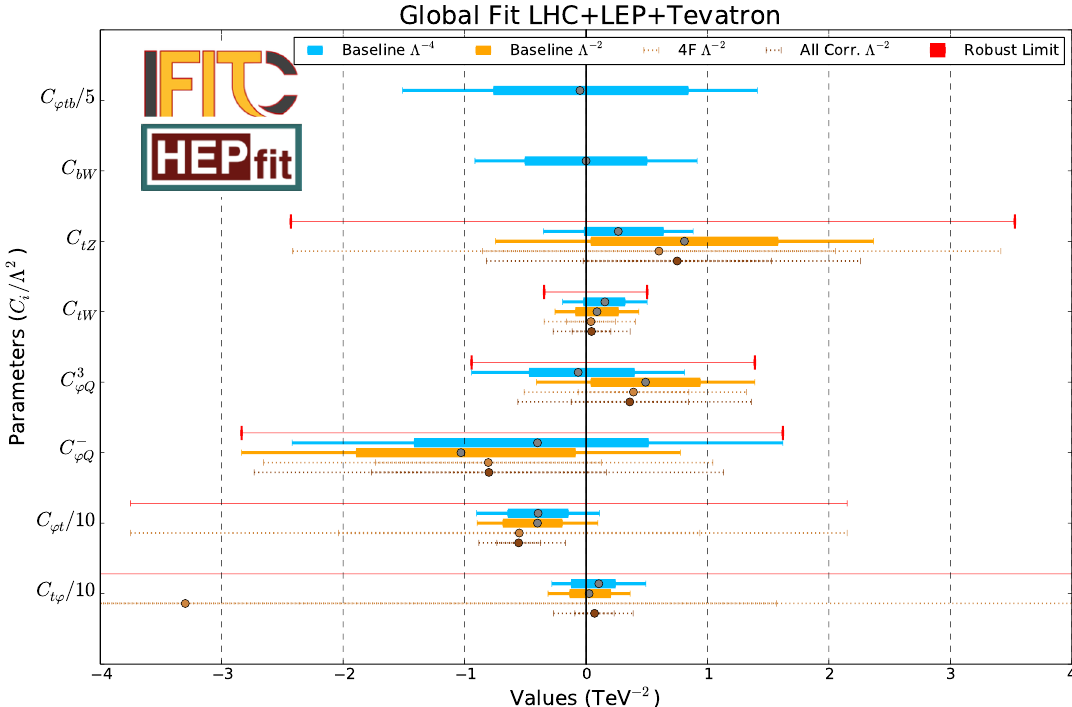
Figure 4 . Results of the global fits with O (Λ − 2 ) (in orange) and O (Λ − 4 ) (in blue) terms. The two thin lines below each of them correspond to additional fits performed to test the robustness of the results: to account for the effects of the inclusion of further operators and for the correlations between all the different measurements (as described in section 8). The red markers correspond to the envelope of those additional fits plus another one that accounts for the theoretical uncertainties on the parameterisations.